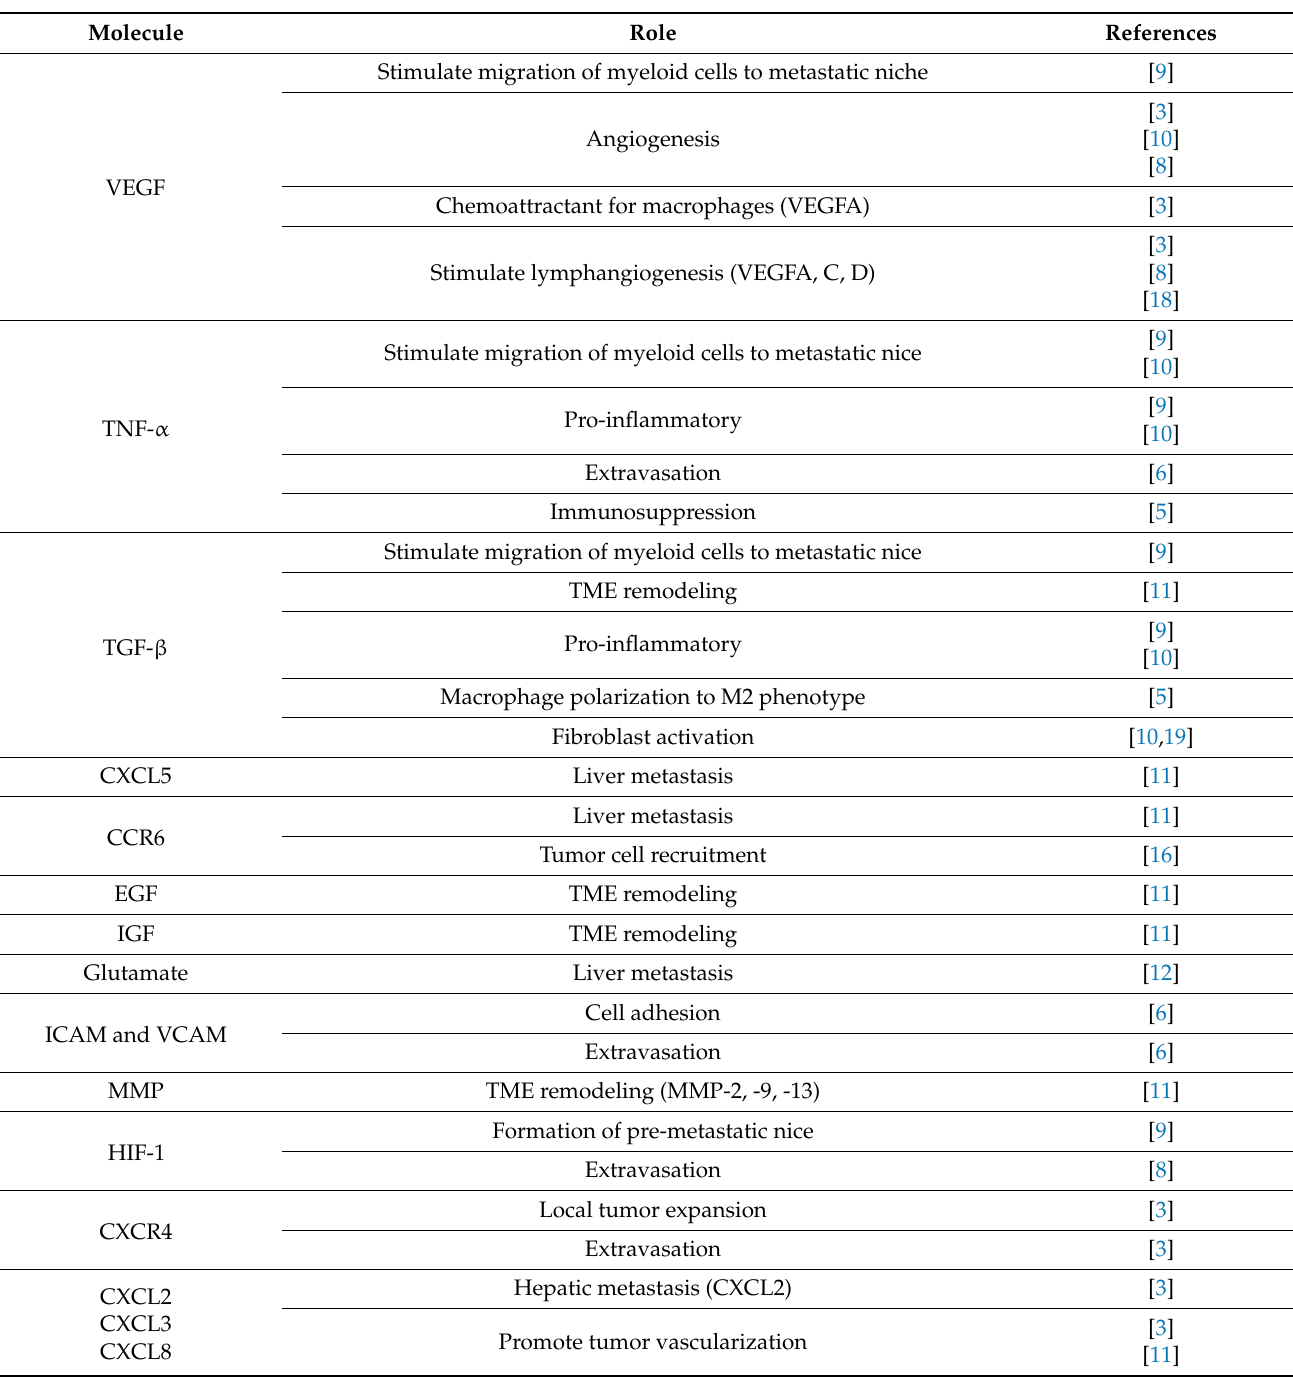
Table 1. Mediators of microenvironment as enhancers of mCRC